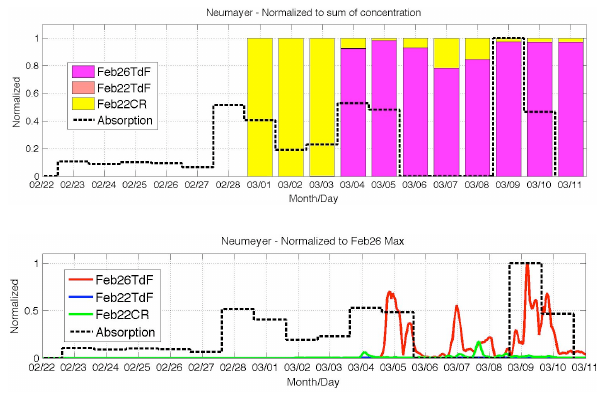
Figure 5: time series of HYSPLIT surface concentrations at Neumeyer for the 3 Fig. 5. Time series of HYSPLIT surface concentrations at simulated dust events described in text and the black line is the normalized aerosol Neumeyer for the 3 simulated dust events described in text and the absorption coefficient measurement at the site. Top plot: the contribution of each run black line is the normalized aerosol absorption coefficient measure- to the total concentration for that day and bottom: concentrations normalized to the ment at the site. Top plot: the contribution of each run to the total maximum of Feb26TdF. The Feb26 event correlates with increases in absorption on March 05 and March09. Dust from the Feb22CR event arrives earlier to Nuemayer concentration for that day and bottom: concentrations normalized to (March01). the maximum of Feb26TdF. The 26 February event correlates with increases in absorption on 5 and 9 March. Dust from the Feb22CR event arrives earlier to Nuemayer (1